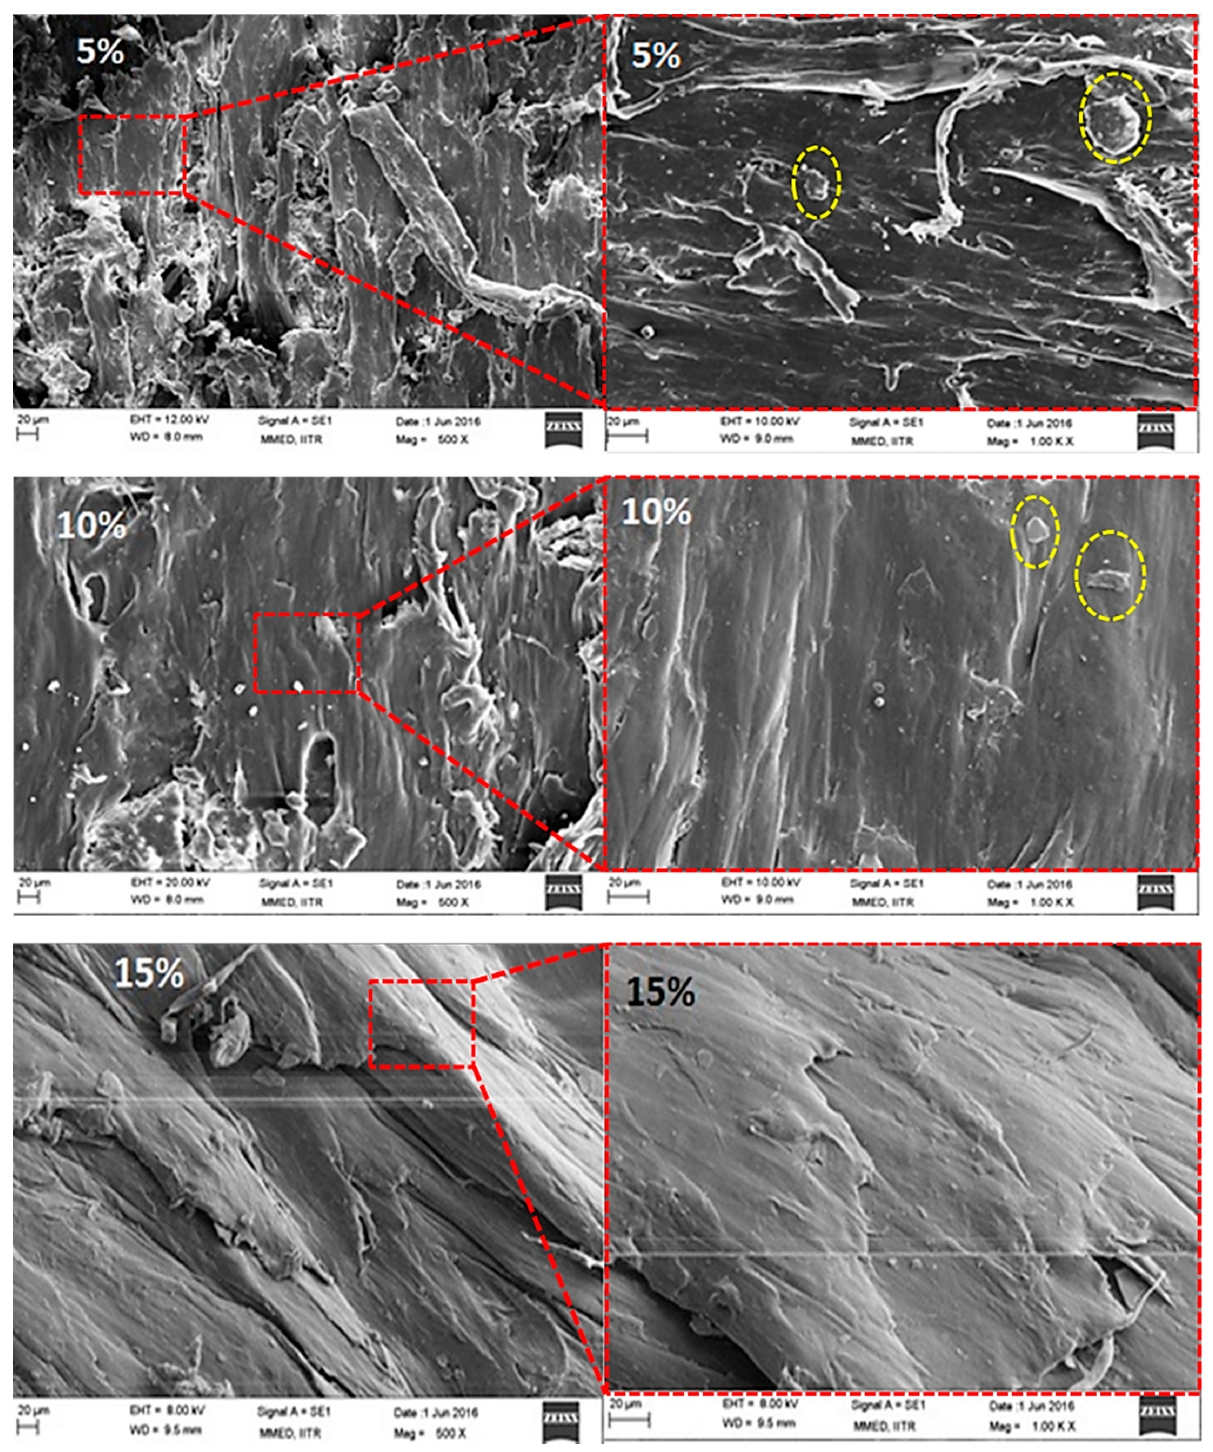
Figure 14. Microscopic images of 5, 10, and 15 wt % of Graphite loaded composite at 500× and 1000×.